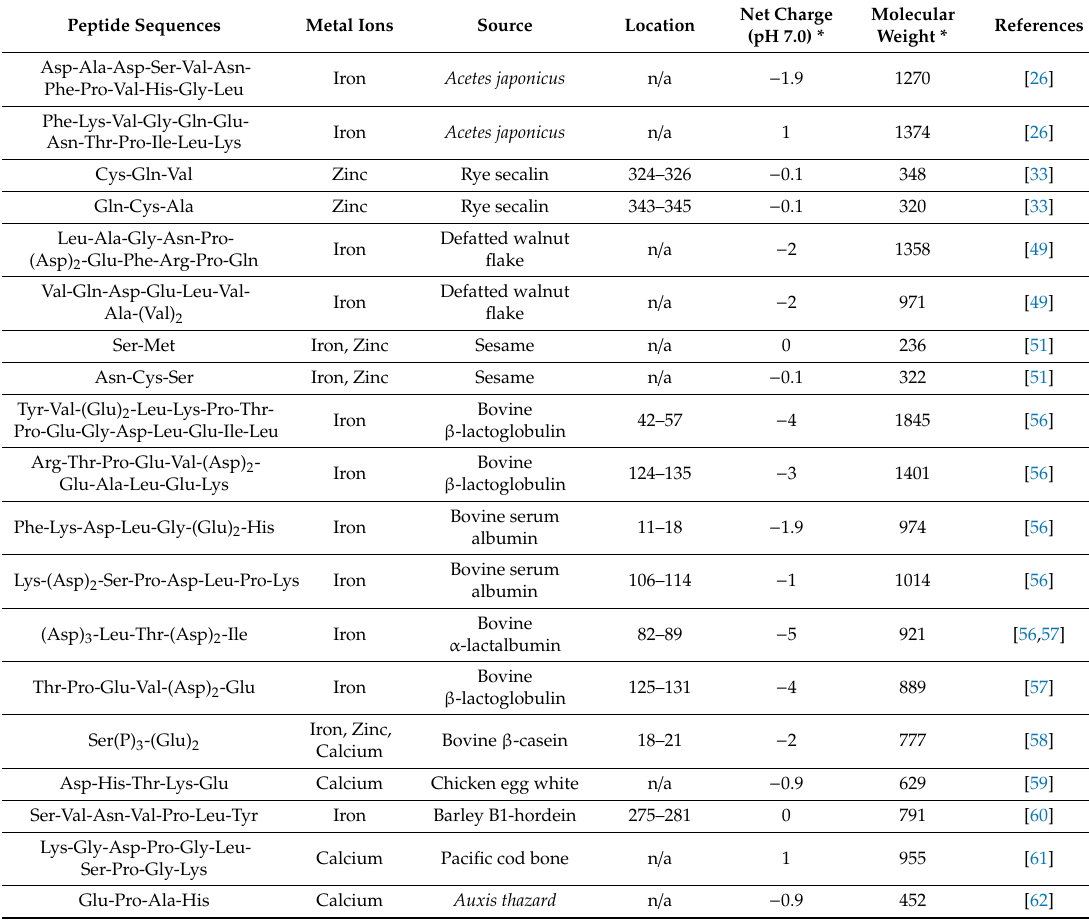
Table 1. Metal-binding peptide sequences from di ff erent protein